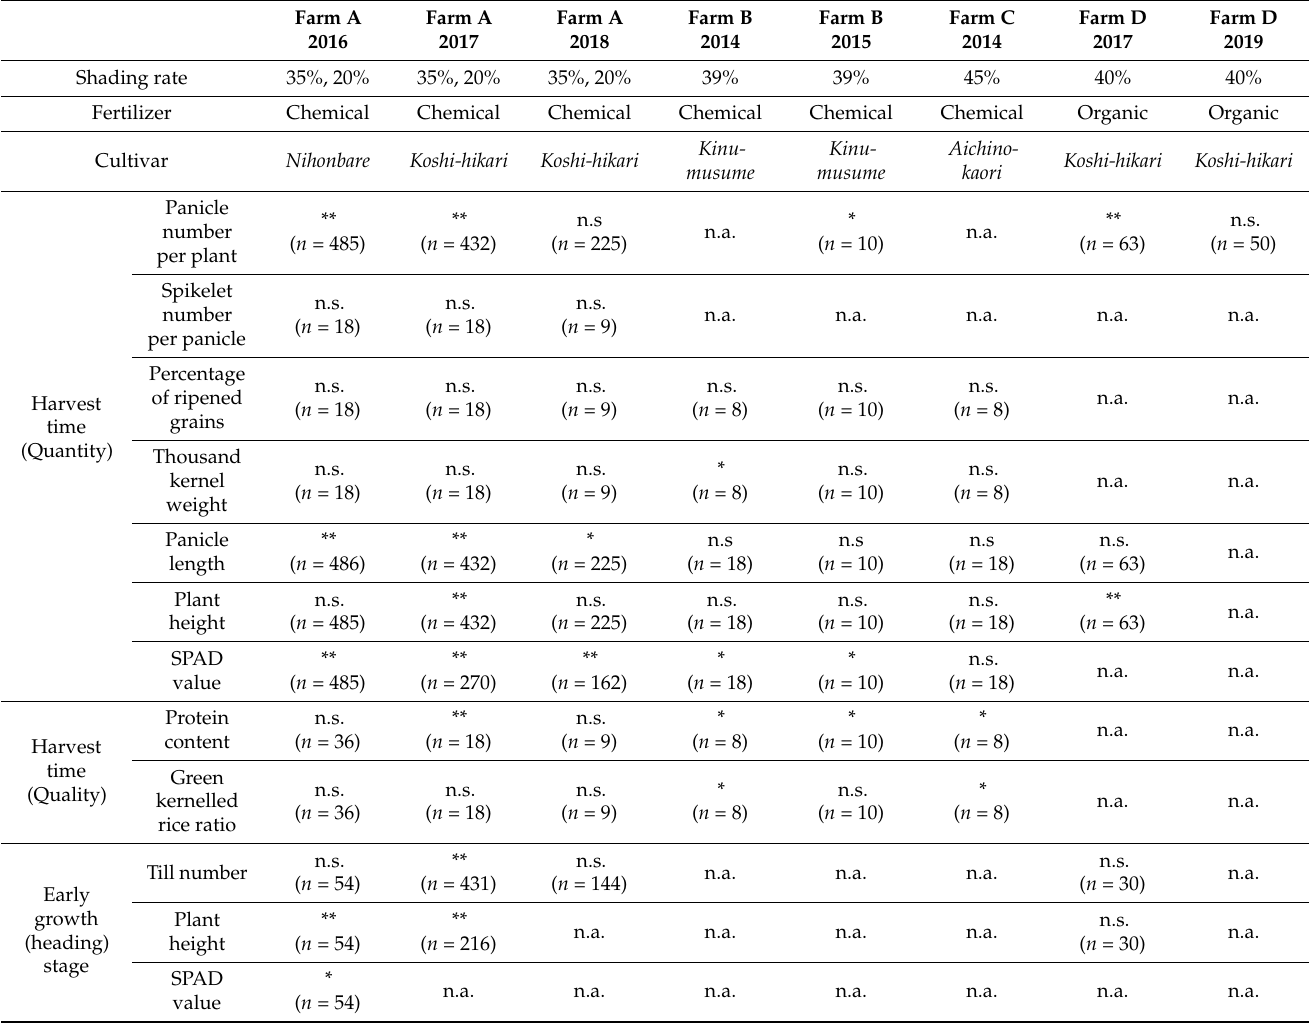
Table 5. Shading effects on rice growth